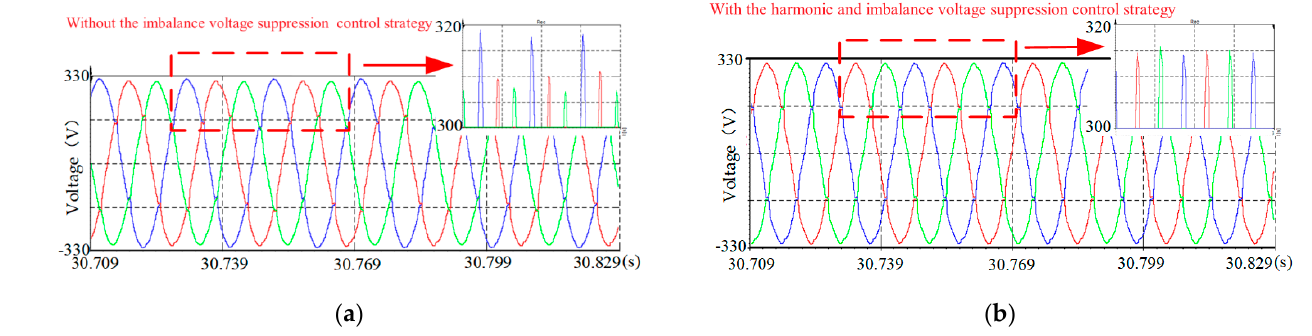
Figure 16. Experimental results for the voltage waveform of microgrid for PCC point ( a ) without the imbalance voltage suppression of multi-inverter parallel VSG adding a secondary control strategy; ( b ) with the harmonic and imbalance voltage suppression of multi-inverter parallel VSG adding a secondary control strategy.